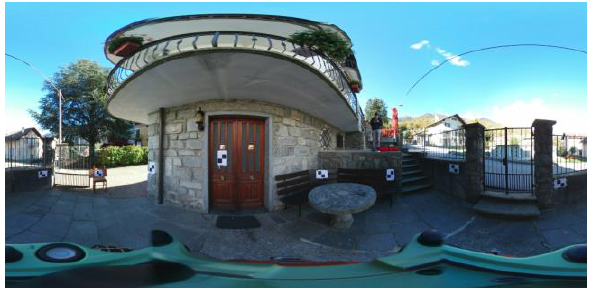
Figure 5. One of the equirectangular projections and the 8 targets used as control and check